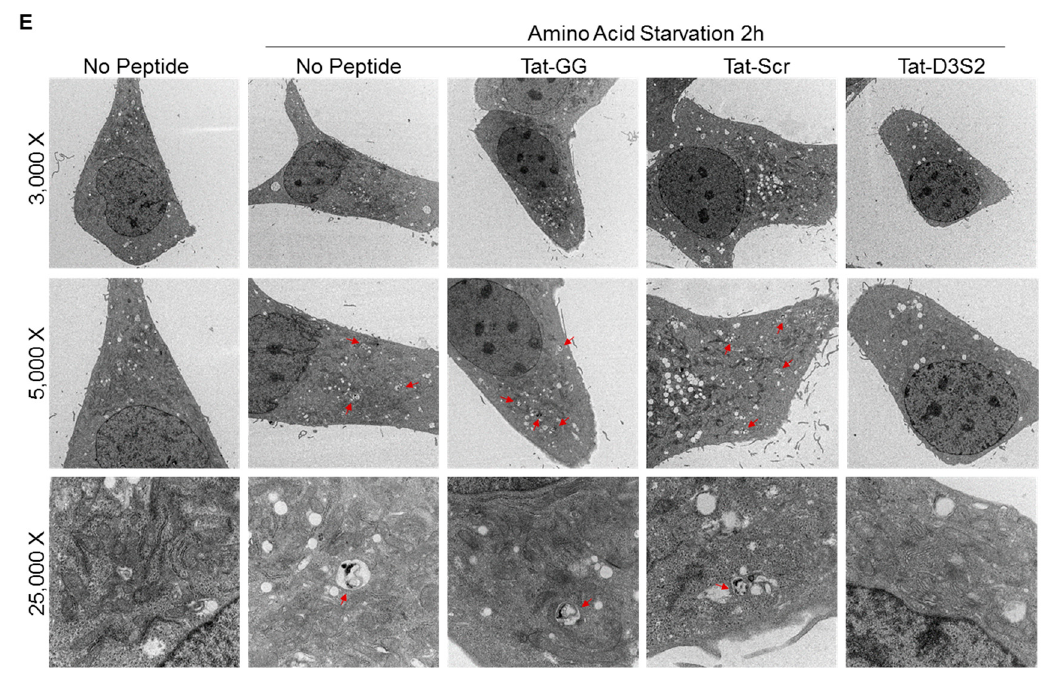
Figure 5. DIRAS3 switch II-derived peptide inhibits amino acid deprivation-induced autophagy in ovarian cancer cells. ( A ) SKOV3 and ( B ) A2780 ovarian cancer cells were seeded in 96-well plates at 1200–2000 cells/well, respectively and treated with indicated peptides (100–200 µM, respectively). The cells were incubated with peptides in full media or media lacking amino acids for 52–76 h, and cell viability was measured by luminescence. The experiment was performed in triplicate and significance denoted by ** p < 0.001. ( C ) SKOV3 and A2780 ovarian cancer cell lines were pre-incubated with the peptide treatments (50 µM) as indicated for 2 h prior to undergoing amino acid deprivation for an additional 2 h. Autophagy induction was determined by the ratio of LC3 II to LC3 I. Treatment with the DIRAS3-derived switch II peptide (Tat-D3S2) significantly inhibited autophagy induction compared to treatment with the control peptides (Tat-GG and Tat-Scr). ( D ) Quantification of the average number of autophagosomes per cell (** p < 0.01) was determined from transmission electron microscopy images performed of SKOV3 ovarian cancer cells following treatment with the peptides and amino acid deprivation as described previously. ( E ) Autophagosomes are represented by double membrane vesicles and denoted with red arrows.